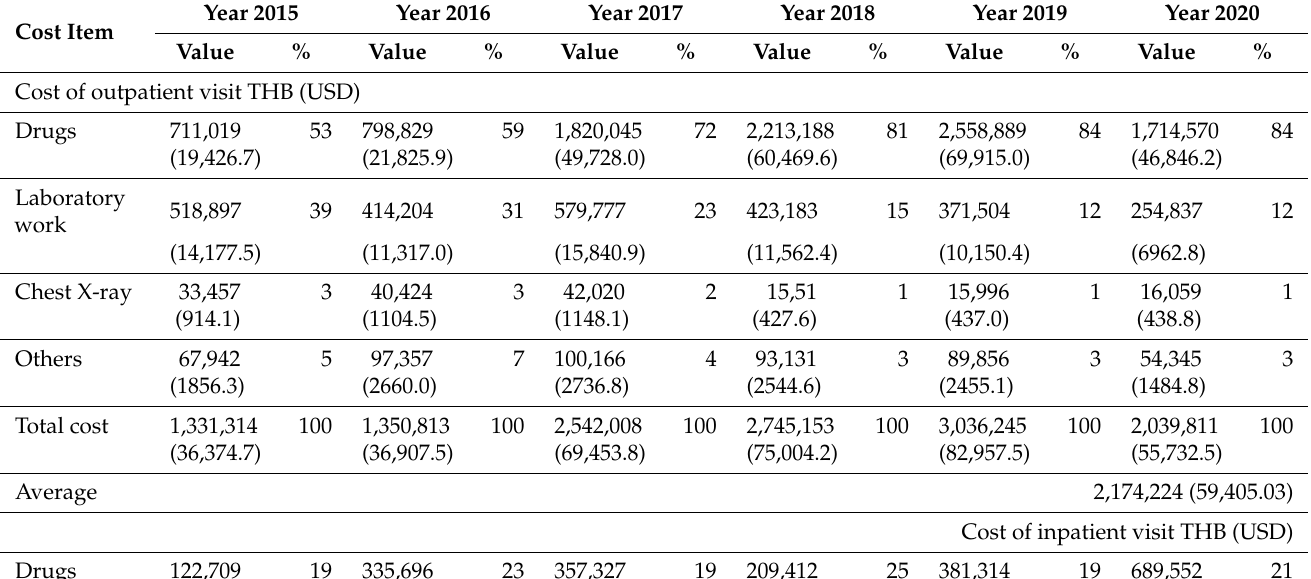
Table 3. Total and disaggregated cost items of outpatients and inpatient